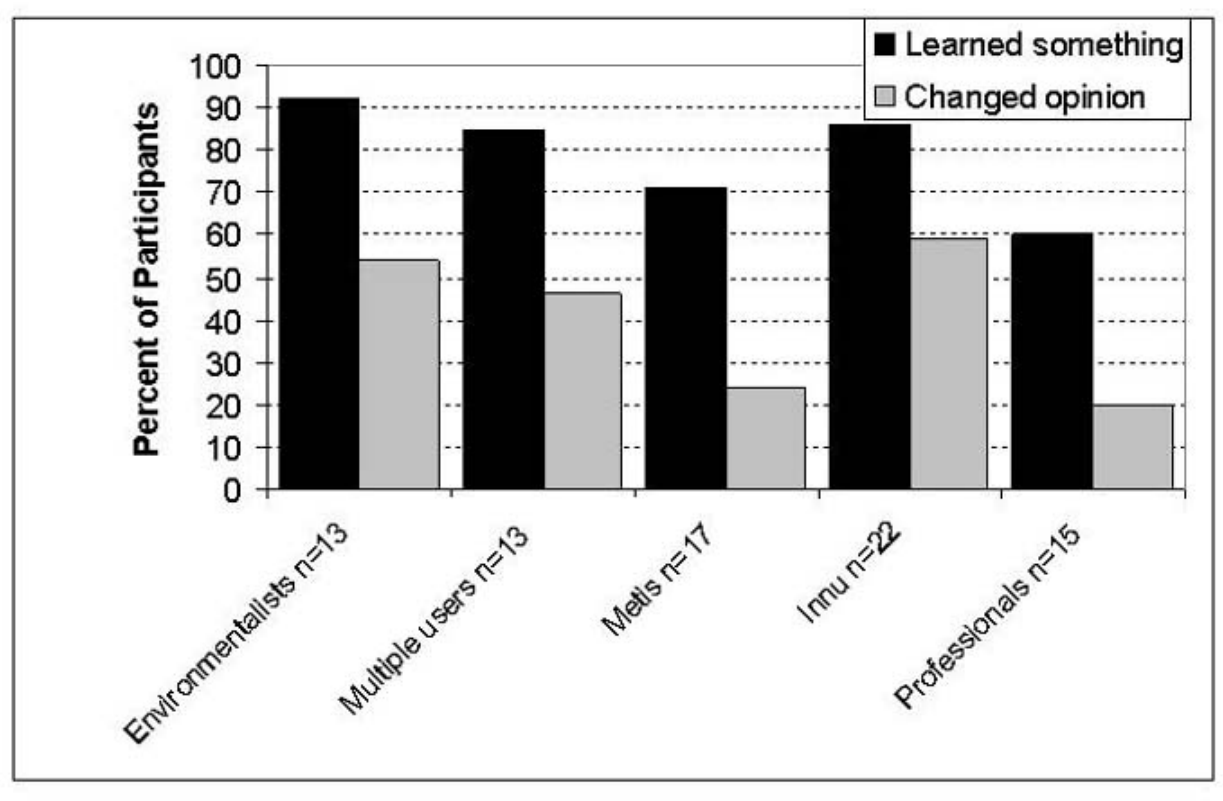
Fig. 6. Self evaluation by different stakeholder groups on learning and opinion change following discussion of simulation results of alternative management scenarios output by the Labrador District 19A Landscape Model